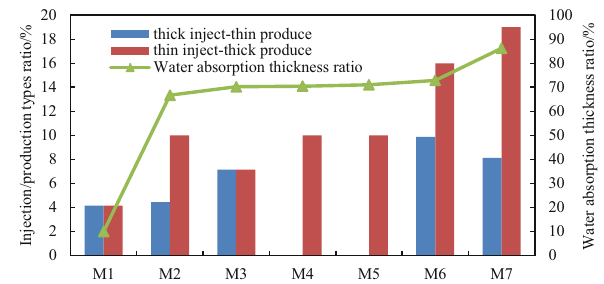
Fig. 15 Relationship between injection/production types ‘‘thick inject–thin produce, thin inject–thick produce’’ ratio and water absorption thickness ratio